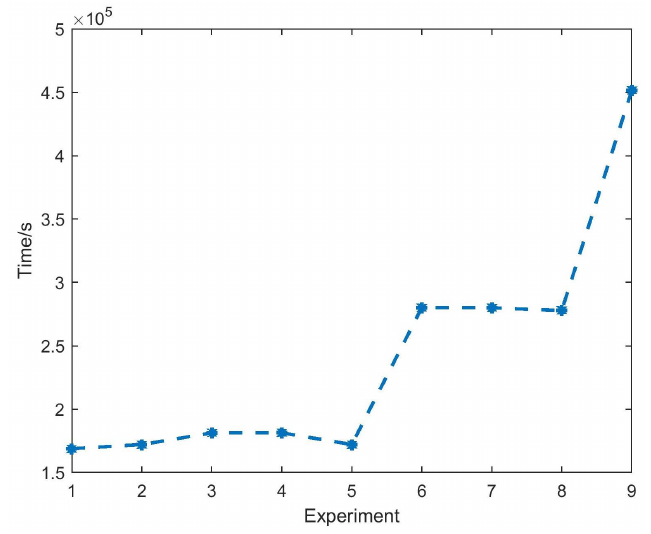
Figure 6. The running time variation plots of experiments 1 to 9 in Table